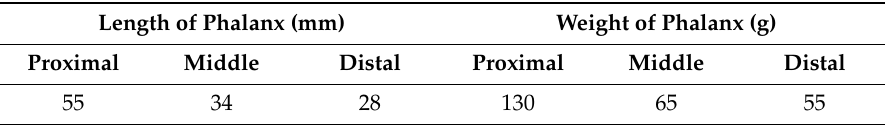
Table 1. Finger parameters of subject.